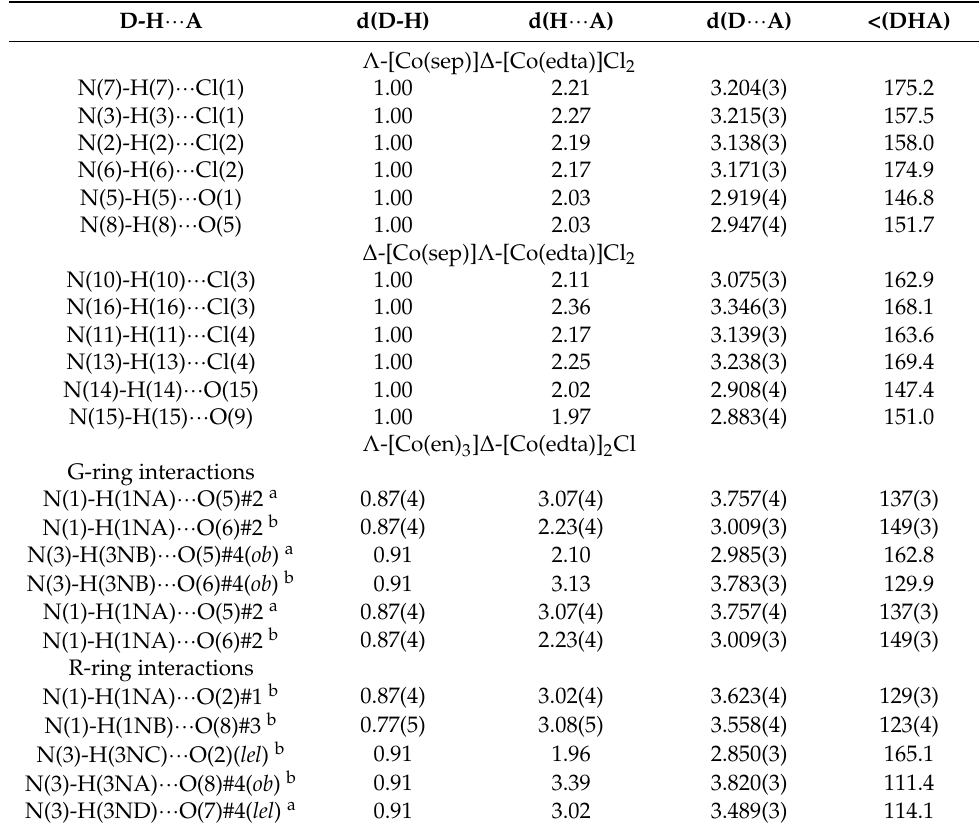
Table 1. Hydrogen bonds between metal-ion complexes [Å and ◦